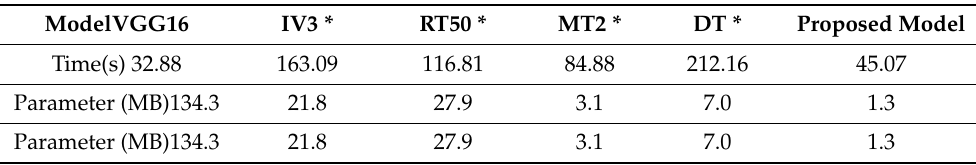
Table 5. Operating speeds of different